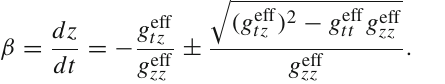
increases as the parallel magnetic component B z does. If ) 2 = ( B z ) 2 = 1 ( B x , the corresponding velocities v 1 and v B B 2